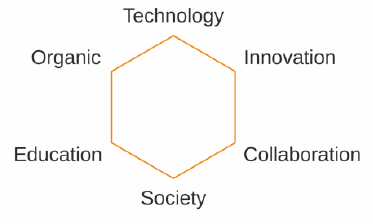
Fig. 6. Keywords that define the main characteristics of